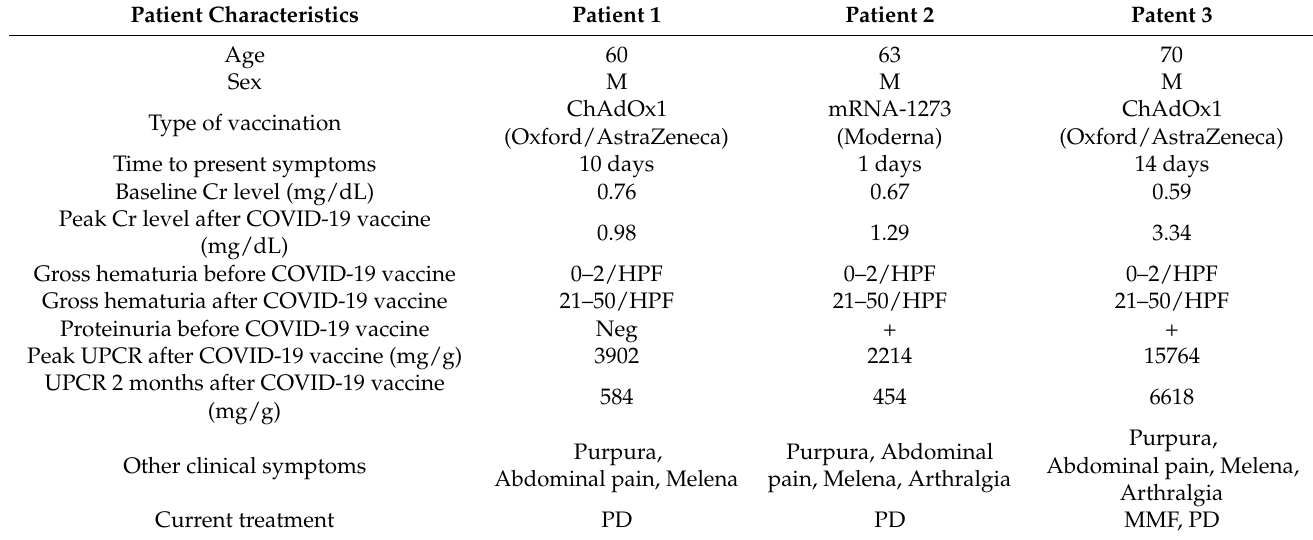
Table 1. Characteristics of the patients with IgA vasculitis after COVID-19